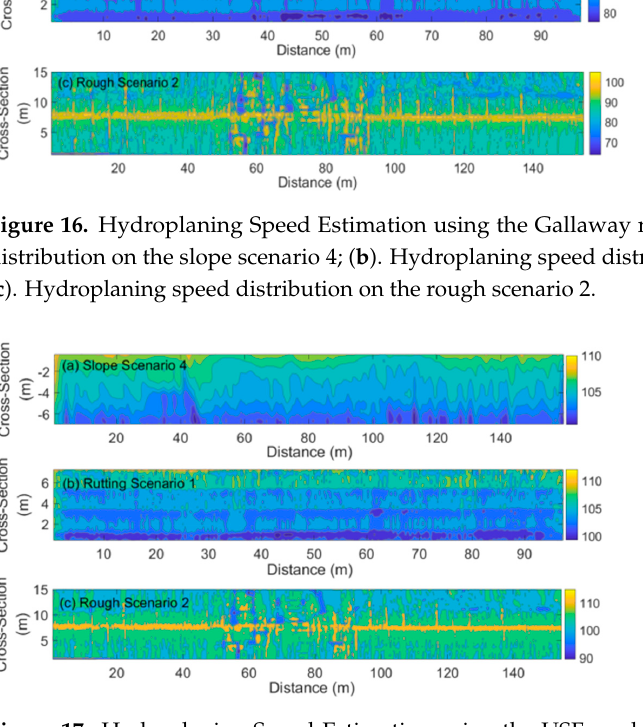
( c ). Hydroplaning speed distribution on the rough scenario